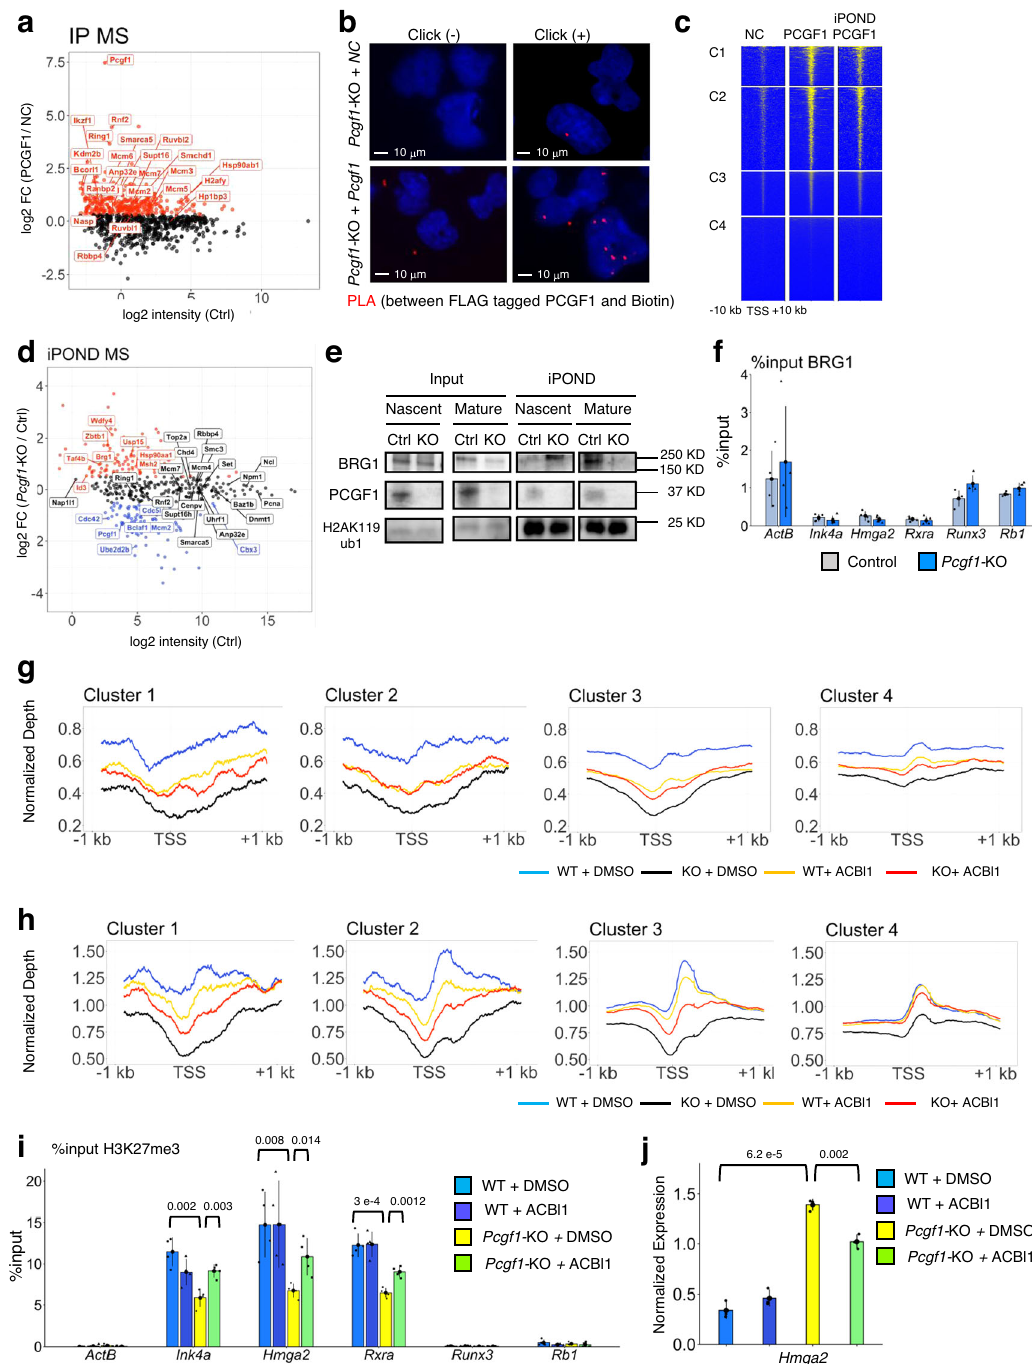
representative C1 genes( Ink4a,Hmga2 , and Rxra